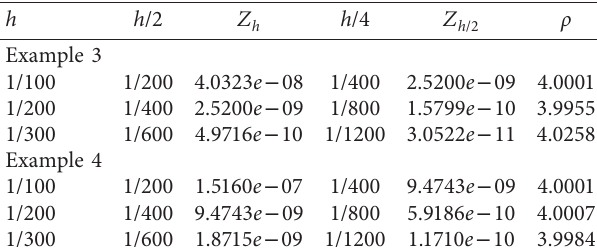
Table 8: Rate of convergence ρ for ε � 0 . 1 and δ � 0 . 03 .